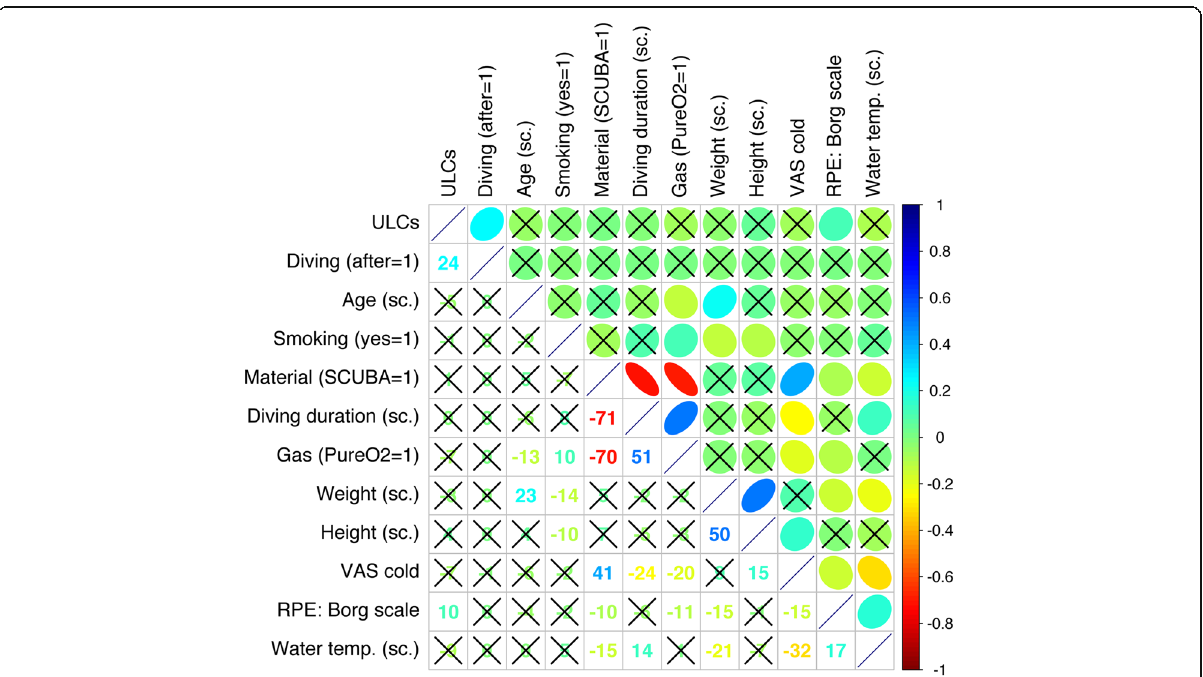
Fig. 2 Correlogram reporting the relationship between the variables. Positive relationship is in color blue and negative relationship in red color. Absence of relation is in white. Non-significant correlations are crossed ( p > .05). In the upper part, an ellipse represents the orientation and the strength of the relation, the narrower the ellipse is, the higher the strength is. In the lower part, the rounded Spearman rho is indicated. Order of the variables is determined by hierarchical clustering with the “ complete ” agglomeration method. “ sc. ” is an abbreviation for scaled (centered and scaled). ULC ultrasound lung comet, SCUBA self-contained underwater breathing apparatus, Gas gas during decompression stop, O 2 oxygen, VAS visual analog scale, RPE rating of perceived exertion, Temp .